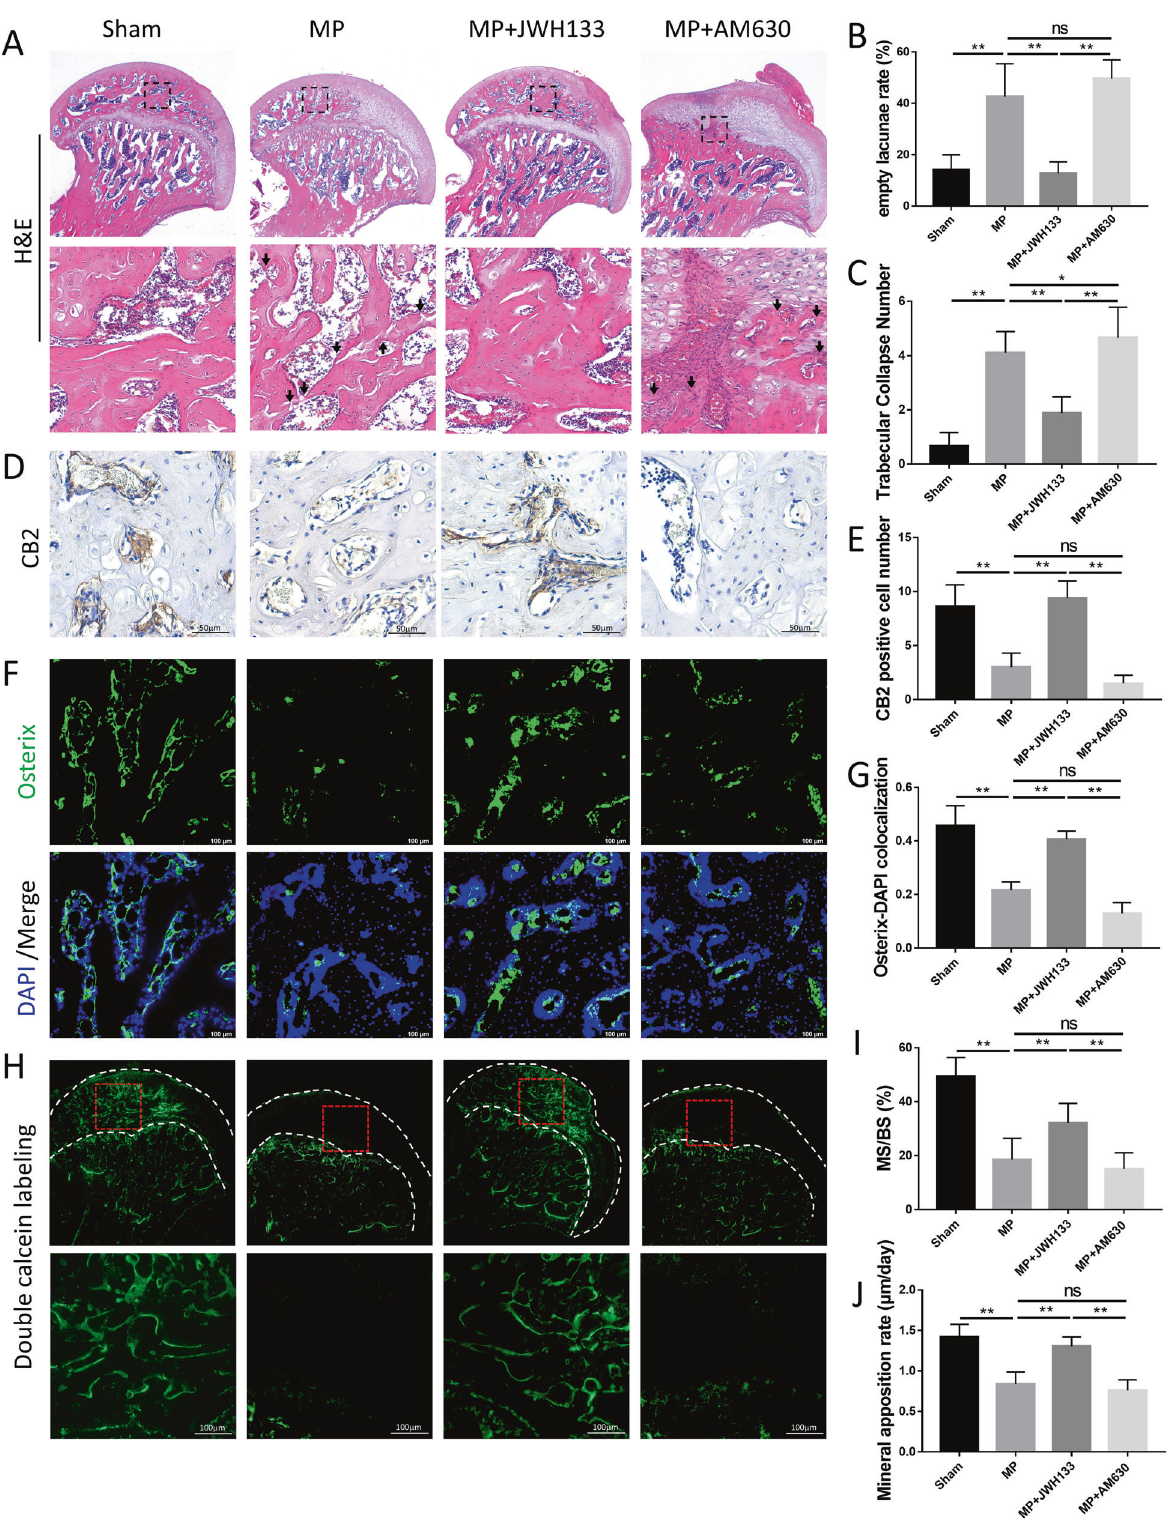
Fig. 3 Histological staining, histomorphometric analysis, and CB2 expression in GC-induced ONFH rat. A – C Hematoxylin and eosin (H&E) staining and histomorphometric analysis. D , E Immunohistochemical analysis showed signi fi cant differences of positive staining. F , G Immuno fl uorescence, green (Osterix), and blue (nuclei). H Representative images of double calcein labeling. I Mineralizing surface/ bone surface (%). J Mineral apposition rate ( μ m/day) ( n = 10 per group, data are shown as mean ± SD, * p < 0.05; ** p < 0.01; ns, not signi fi